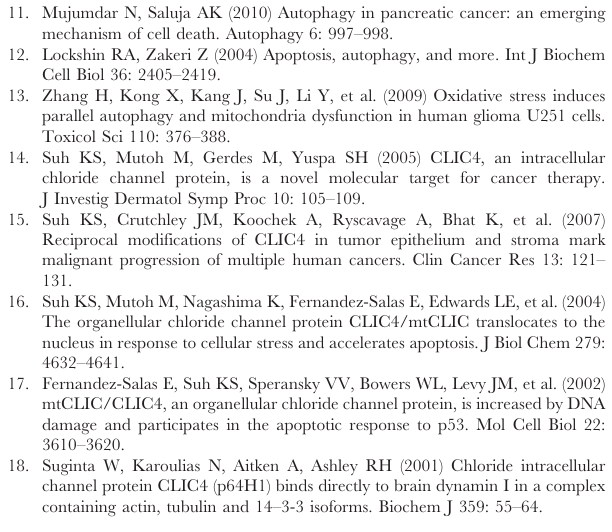
Figure S1 Analysis of CLIC4 expression in U251 cells transfected with CLIC4 siRNA. (A) Western blot analysis of CLIC4 expression in U251 cells transfected with encoding empty vector, CLIC4-siRNA-S and CLIC4 siRNA vectors for 24 h (B) Densitometric analysis of CLIC4 levels. Data were presented as a mean 6 SD of three independent experiments. * P , 0.05 versus control group. Figure S2 Analysis of CLIC1 and CLIC5 expression in U251 cells transfected with CLIC4 siRNA for 24 h and 48